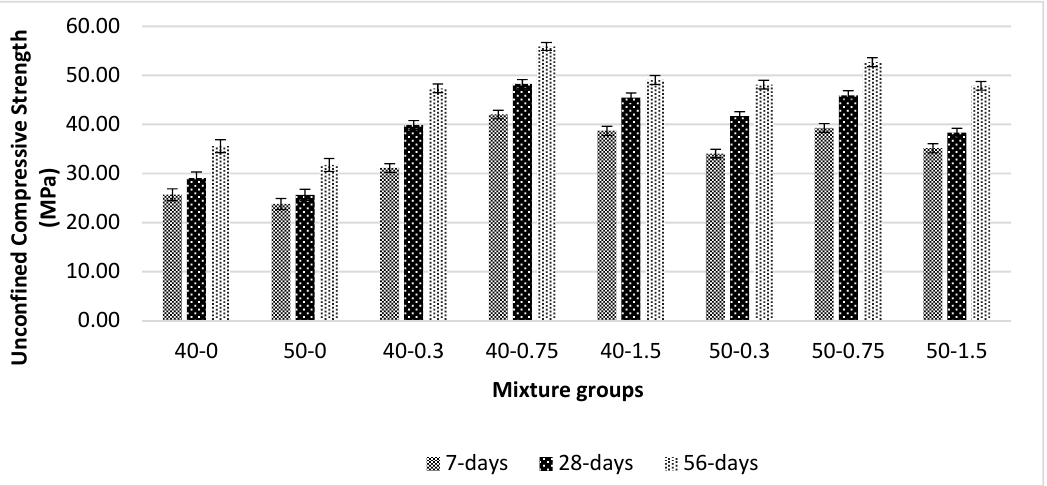
Figure 7. Unconfined compressive strength values for basalt-reinforced bottom ash cement paste composites at 7, 28 and 56 days of curing.